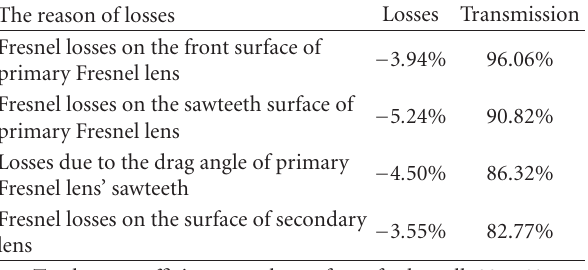
− 3 . 94% 96.06% − 5 . 24% 90.82% − 4 . 50% 86.32% − 3 . 55% 82.77%